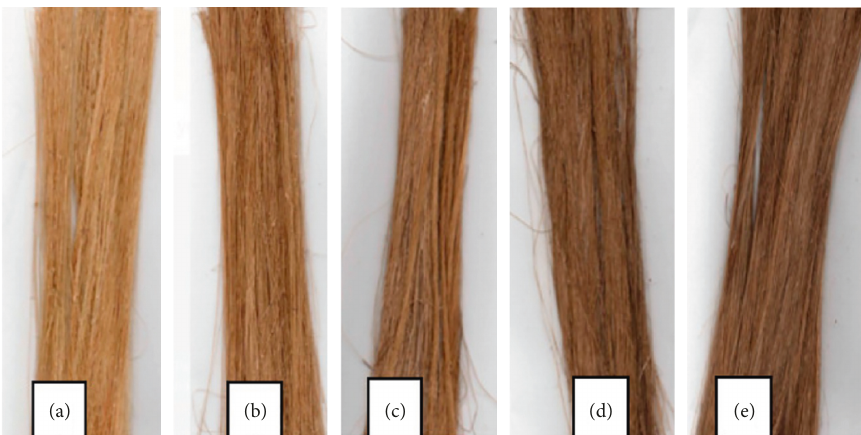
Figure 2: Effect of liquid smoke immersion on the color change of KPLF: (a) TP, (b) P1J, (c) P2J, (d) P3J, and (e)